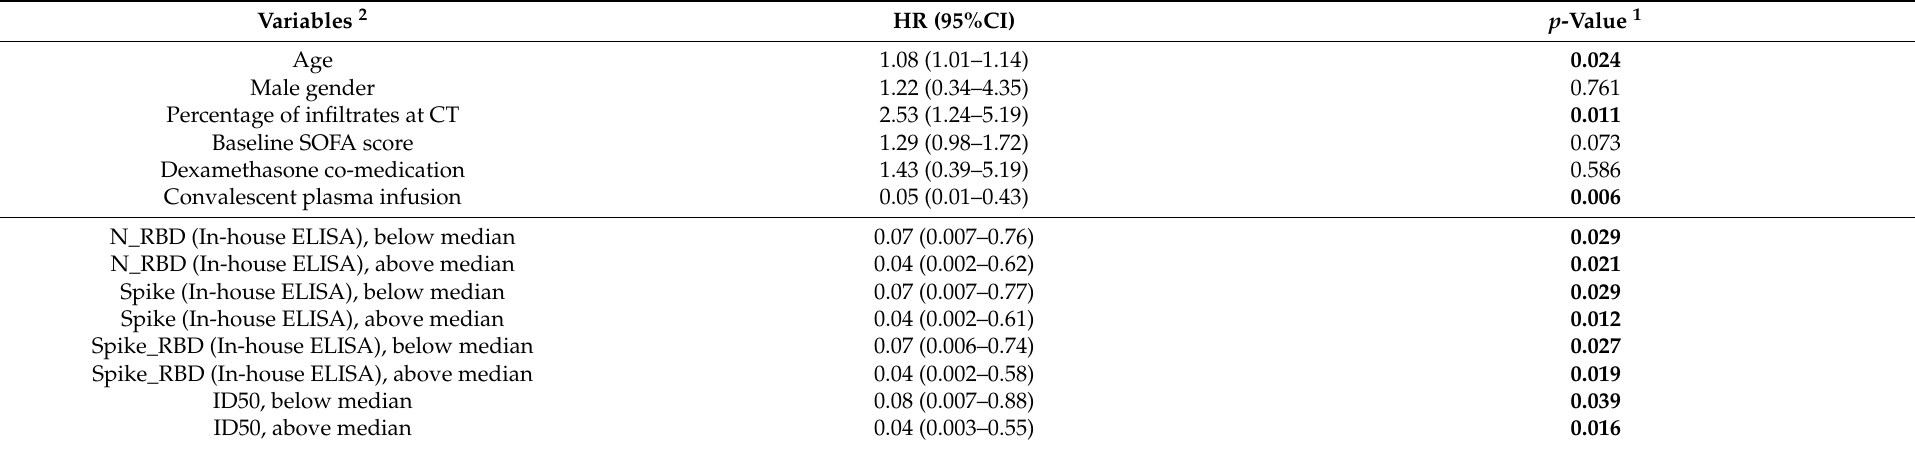
Table 3. Results of univariate Cox regression analysis for the association between the convalescent plasma infusion and the antibody levels in the infused plasma and overall